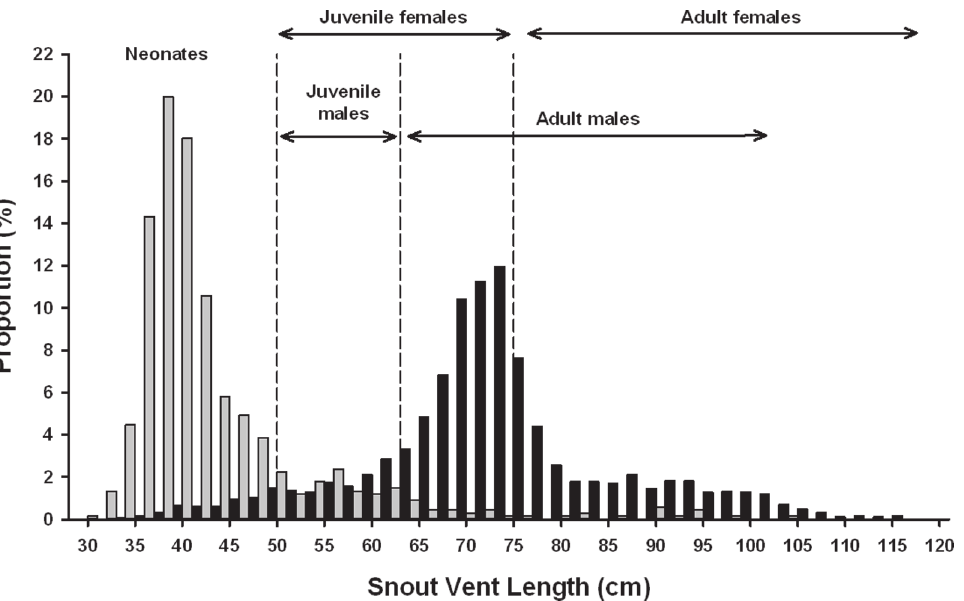
Figure 2. Comparison of the body size distribution (hence age structure) of two islets. The proportion of individuals (Y-axis) in each 2 cm - SVL interval (X-axis) is indicated with gray bars for Ouen Island versus black bars for Signal Island. Vertical dashed lines indicate the limit between the main age classes (see text for details). Ouen Island contains a main cohort of neonates, a second smaller cohort of juveniles, and few adults. In strong contrast, Signal Islet contains essentially adults. Both sites have been monitored at least 5 times and they shelter large number of individuals (N=679 observations in Ouen Island, N=1,987 in Signal).